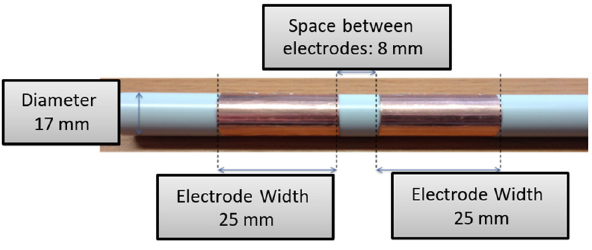
Figure 7. Sensor optimized design.